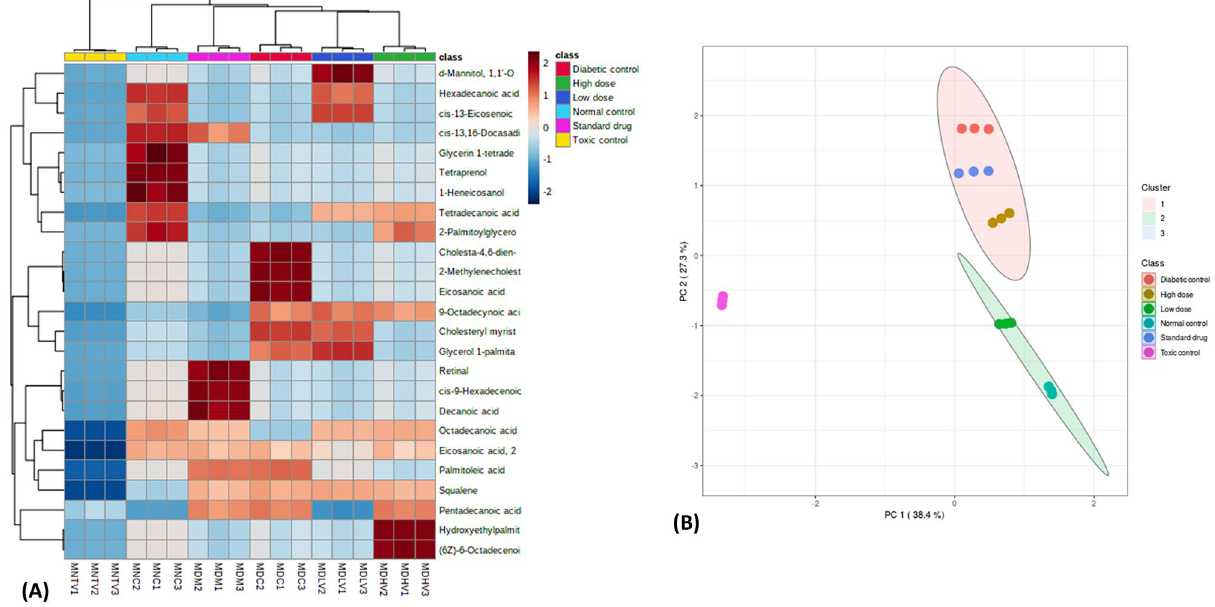
Figure 9. ( A ) Heat map; and ( B ) Score plot between the selected PCs of GC–MS identified lipid metabolites.